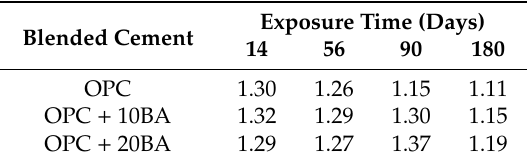
Table 2. Corrosion index at four exposure times. Blended